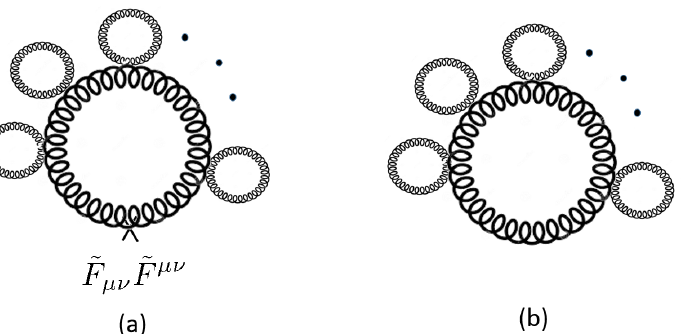
Figure 2. Diagrams relevant for ( a ) gauge coupling ( b ) cosmological constant; the curly lines represent